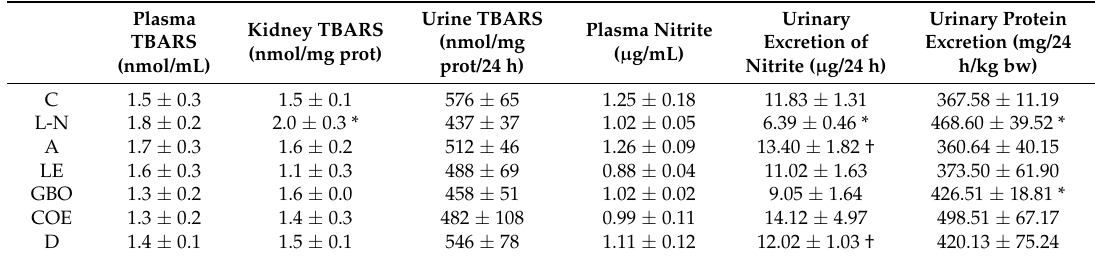
Table 3. Measurements of TBARS, nitrite and proteinuria in the experimental